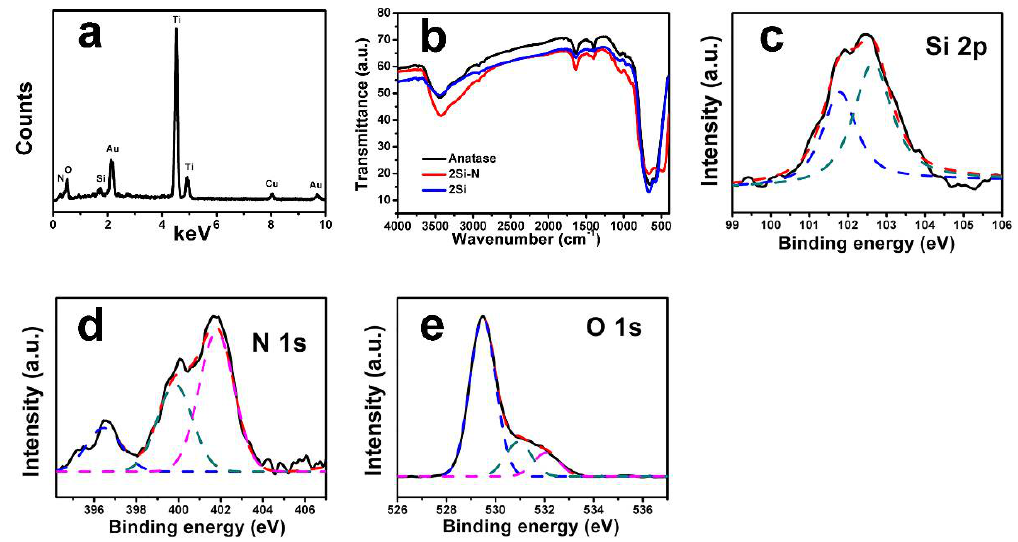
Figure 5. Results of ( a ) energy dispersive X-ray spectrometer (EDS) (the peaks at 2.1 keV and 9.7 keV are due to the conductive Au coating), ( b ) Fourier transform infrared spectra (FTIR), and ( c , d , e ) X-ray photoelectron spectra (XPS) analyses of the sample 2Si-N.